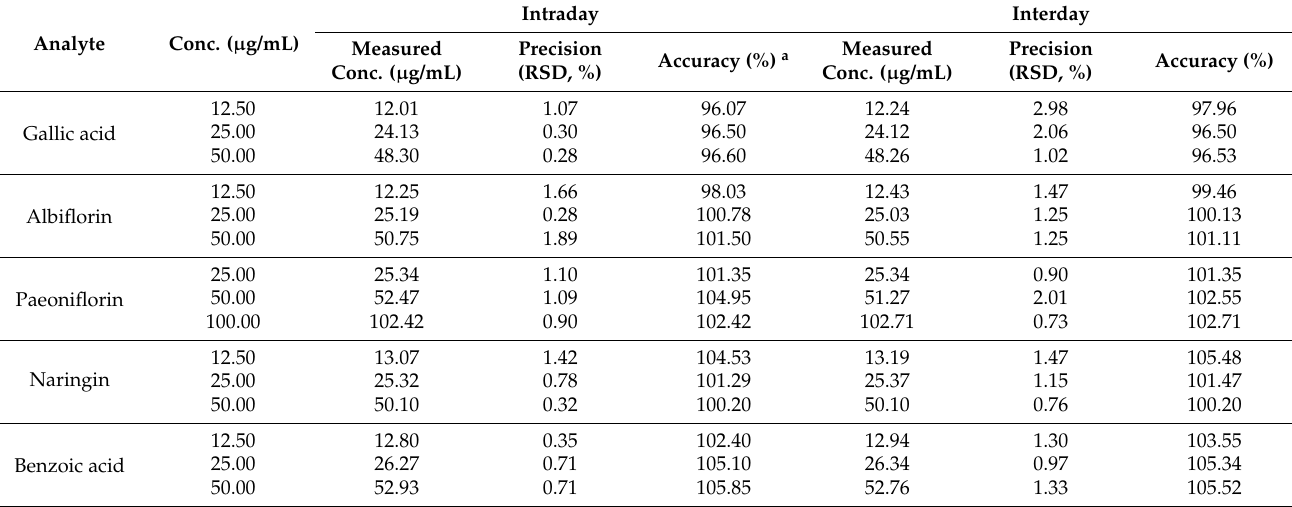
Table 3. Precision date of the 10 markers in the developed HPLC assay ( n =